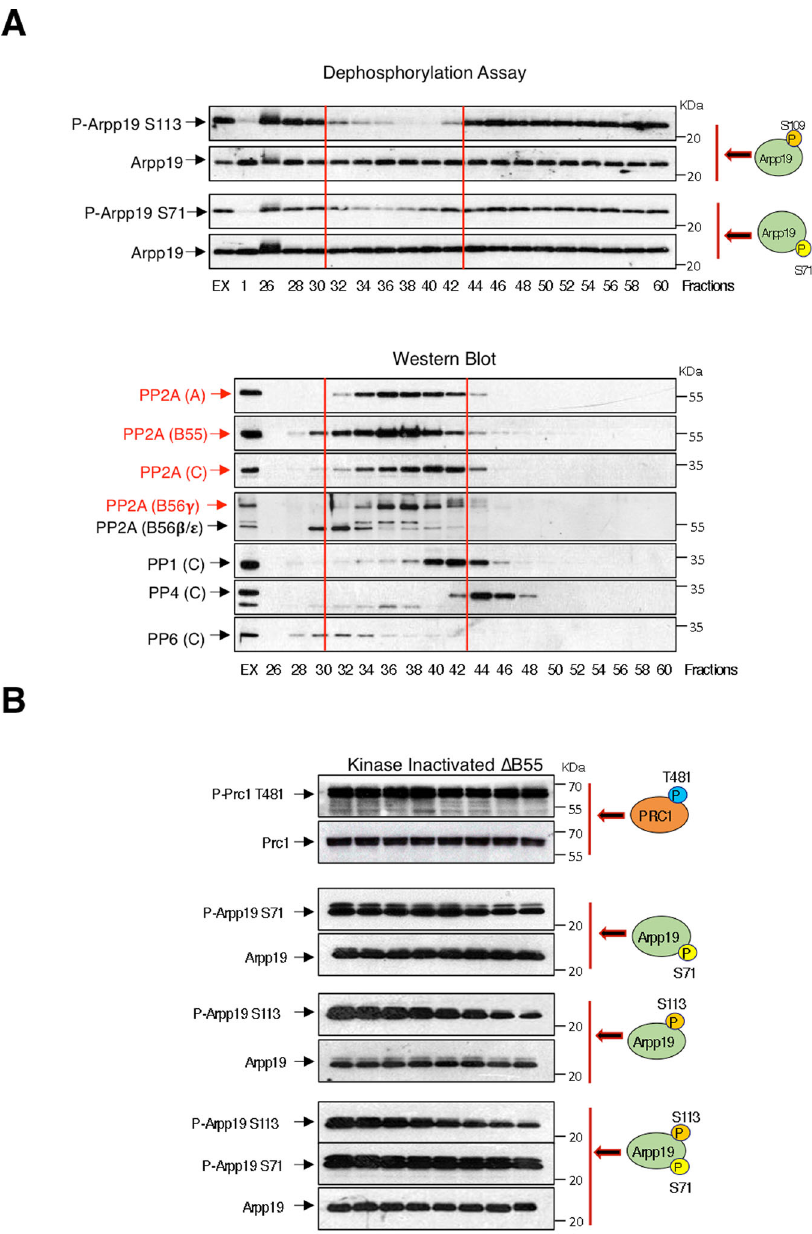
Fig. 8 PP2A-B55 is the phosphatase responsible of the dephosphorylation of Arpp19 on S109/S113. A Kinase-inactivated Xenopus egg extracts were submitted to gel fi ltration chromatography and eluted fractions subsequently supplemented with Arpp19 phosphorylated ‘ in vitro ’ on either S109/S113 or S67/S71. The dephosphorylation of these residues and the amount of Arpp19 were then measured by western blotting (upper panels, dephosphorylation assay). ‘ EX ’ and 1 correspond to phosphorylation at time 0 and 10 minutes respectively, of the indicated residues upon directly mixing with a kinase- inactivated extract. The presence of the indicated proteins in elution fractions and in the kinase-inactivated extract sample were assessed by western blotting (lower panels, western blotting). Red lines highlight the fractions displaying S109/S113 and S67/S71 dephosphorylation activity. The name of the proteins whose level picked in these fractions are also depicted in red. B Prc1 ‘ in vitro ’ phosphorylated on T481 by puri fi ed Cyclin A/Cdk and Arpp19 phosphorylated on either S67/S71 or on S109/S113 were supplemented together or separately to kinase-inactivated extracts depleted of B55 and the dephosphorylation of the corresponding residues analysed over the time by western blotting. Data of the fi gure are con fi rmed in three different